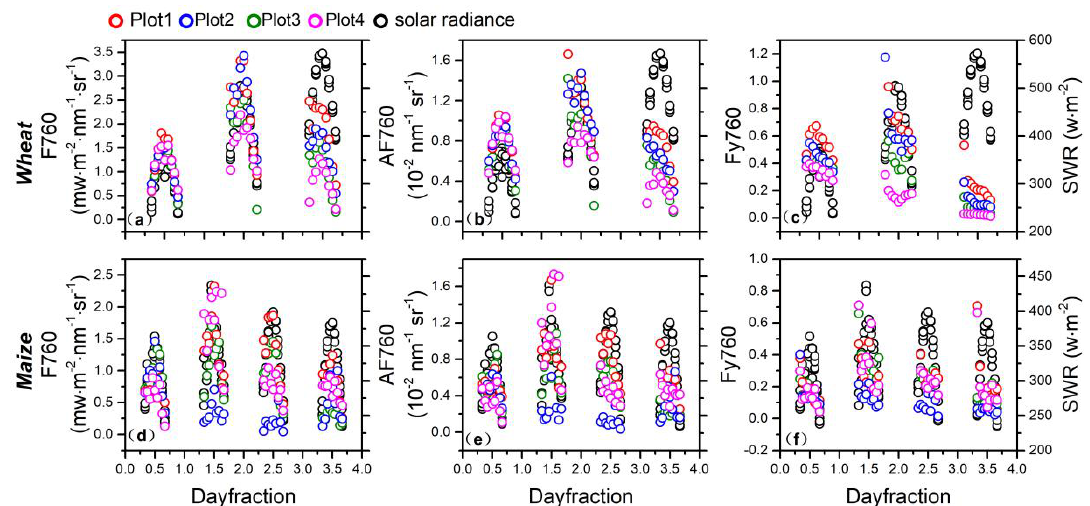
Figure 5. Daily patterns of F760 (first column), AF760 (second column), and Fy760 (third column) from wheat ( a – c ) and maize ( d – f ) compared with respective solar radiation (SWR). The circles in the figure represent the hourly values that were averaged from the 15-day measurements for wheat and maize. The detailed time periods of wheat were 28/3–11/4, 14/4–28/4 and 12/5–19/5, and the time periods of maize were 29/7–11/8, 12/8–26/8, 27/8–10/9, and 11/9–24/9. The fourth pattern of wheat was only calculated based on the measurements from a week because of the terminal of the field campaign.